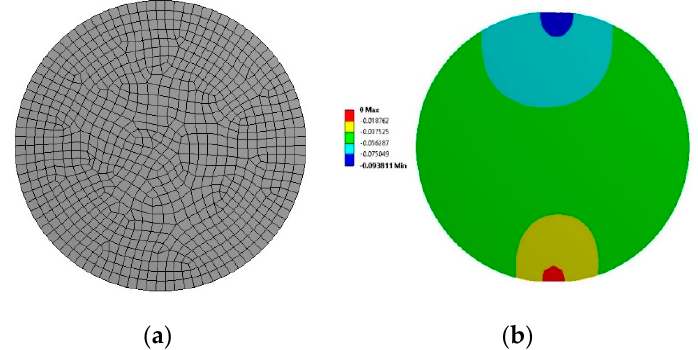
Figure 10. Cylinder under load P solve with FEM. ( a ) Mesh used in FEM software. ( b ) Cylinder deformed solved with FEM software; the plot colors represent the displacement in Y direction.